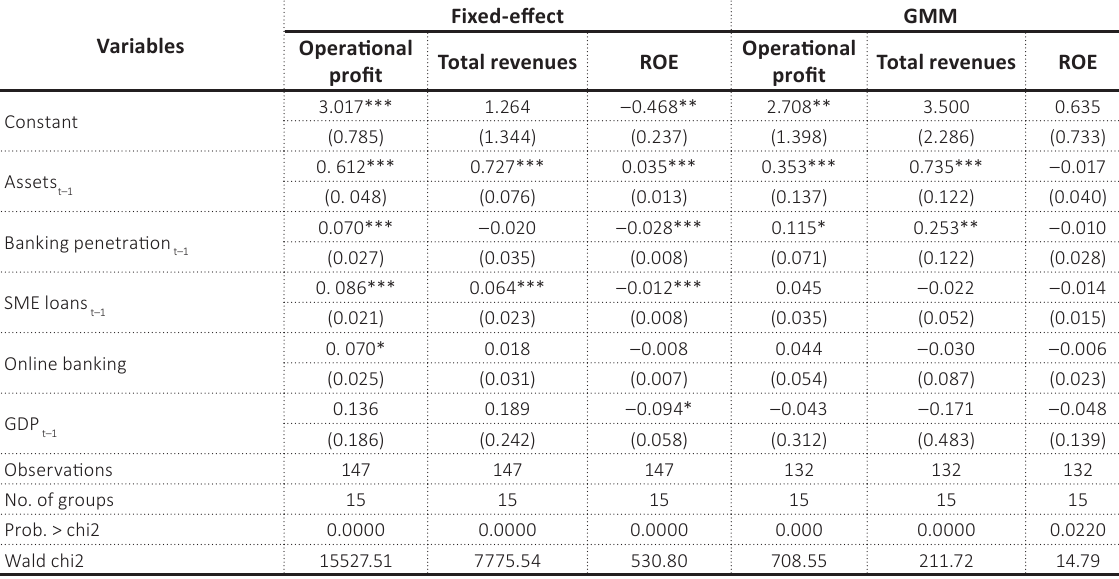
Table 7. Fixed-effect and GMM estimation